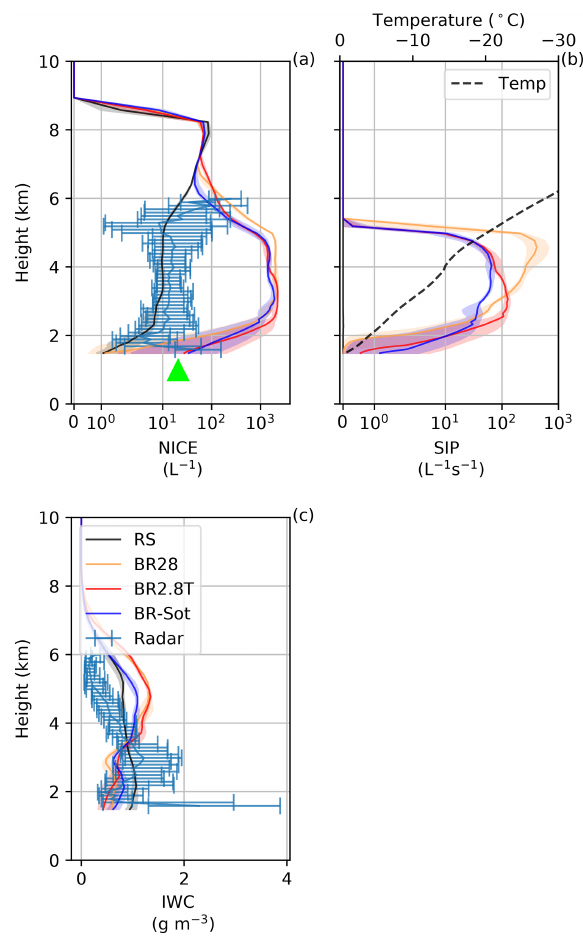
Figure 6. Vertical profiles for the (a) ice number concentration (NICE), (b) secondary ice production (SIP) and (c) ice water con- tent (IWC). The solid lines are the mean, with shaded areas and error bars showing the 10th and 90th percentiles for the model simulations and Doppler radar, respectively, at 15:30UTC. The green triangle is the 2DVD surface observations for hydrometeors D > 0 .